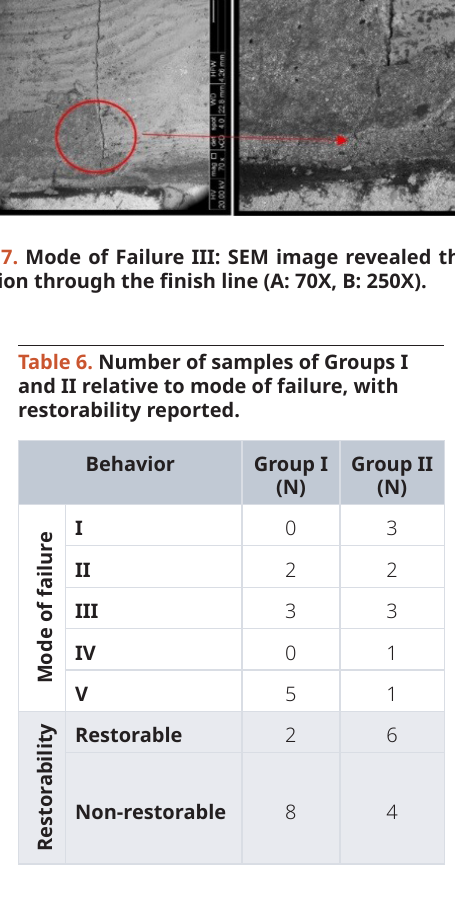
Table 7. The von-Mises stress values for each model. Red dot marks the higher value.